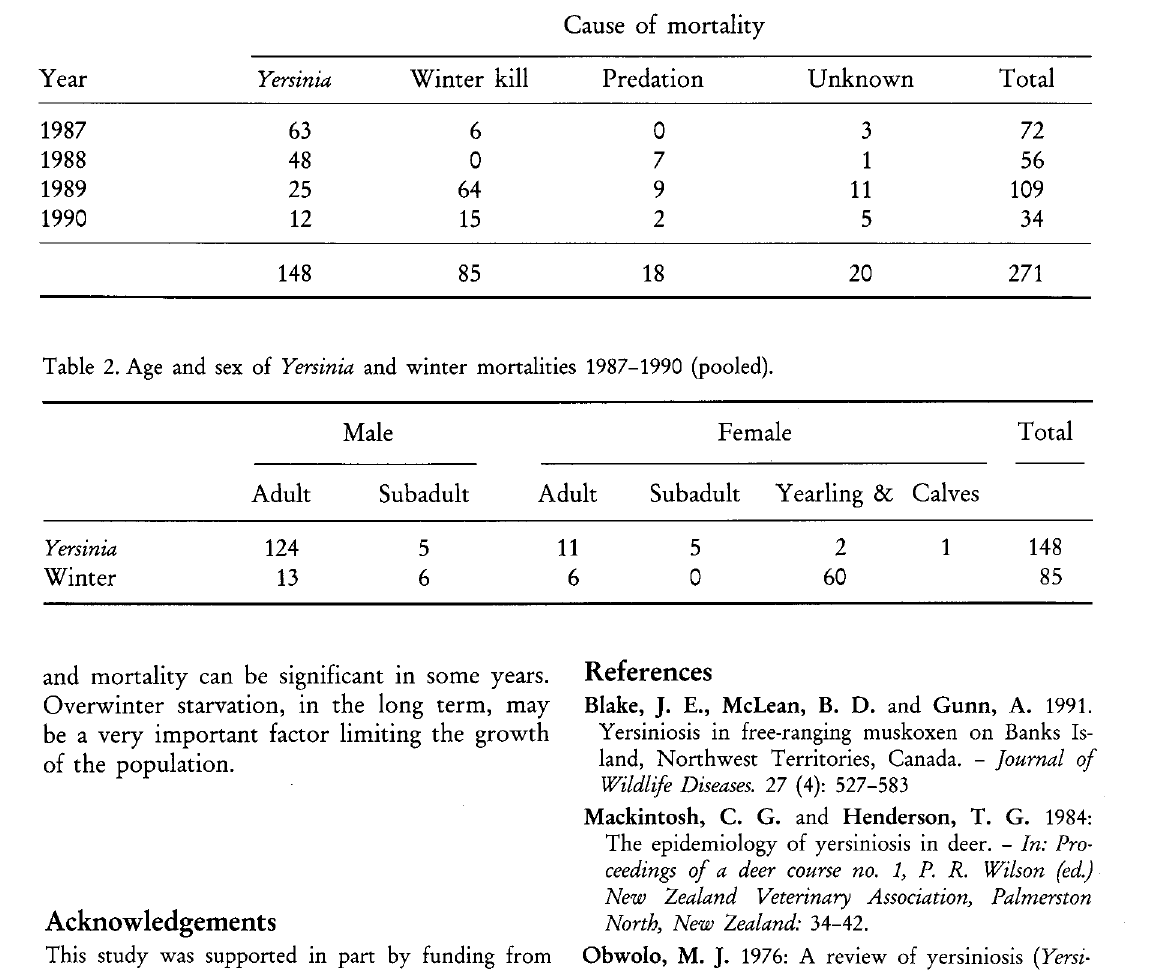
Table 1. Cause of mortality in the Muskox River study area 1987-1990.